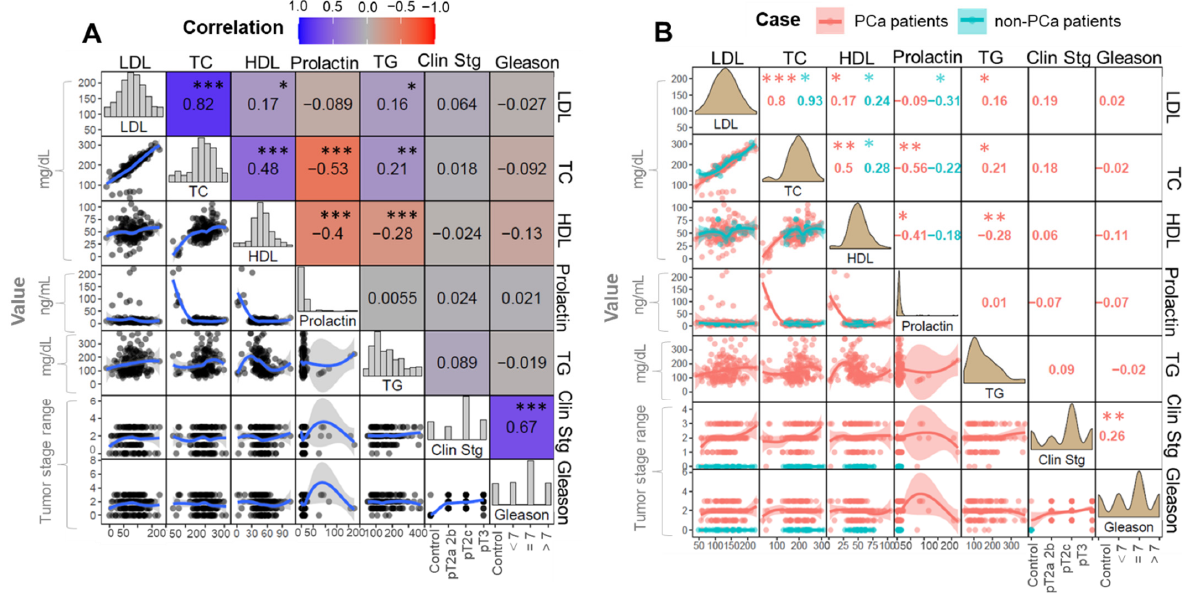
Figure 3. Plots showing the correlations between biochemical parameters in blood and cancer stag ‐ ing (in terms of clinical stage and GS)—with the respective correlation coefficients calculated based on ( A ) all investigated samples or ( B ) separately, according to the study groups. The numerals inside the boxes refer to the Spearman coefficient (rho) found for the given bicorrelation. The symbols “***”, “**” and “*”, correspond to p < 0.001, ≤ 0.001 and ≤ 0.05, respectively. LDL = low density lipo ‐ protein, TC = total cholesterol, HDL = high density lipoprotein, TG = triglycerides and Clin Stg = cancer clinical staging.